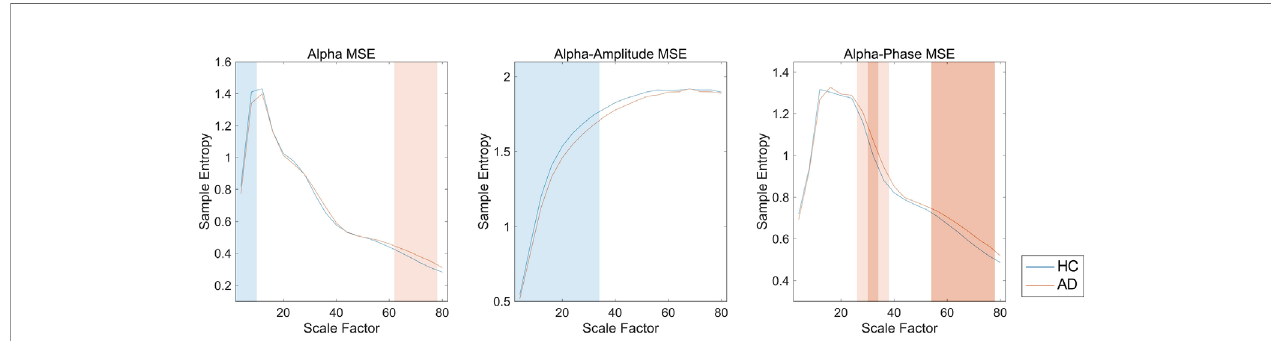
FIGURE 3 | Spectral, amplitude, and phase multiscale entropies (MSEs) of the alpha band in the temporal region. Blue and red lines respectively show healthy controls (HC) and Alzheimer ’ s disease (AD); blue and red shaded areas respectively show HC > AD and HC < AD; dark and light shaded areas respectively represent p < 0.01 and p < 0.05. False discovery rate (FDR) q corrections were controlled for 20 scale factors (SFs).